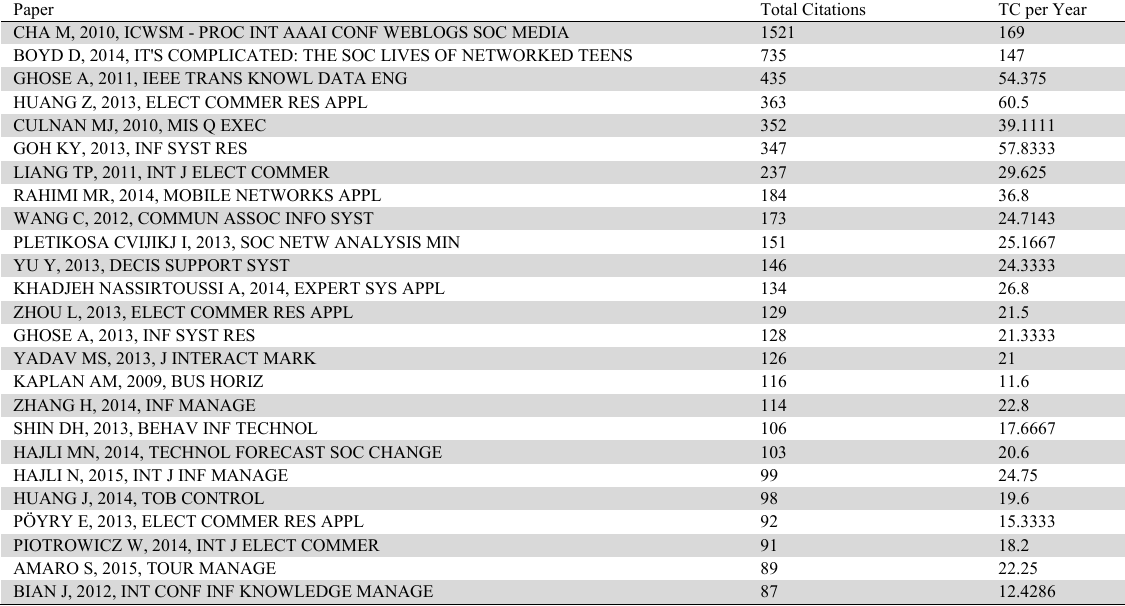
The summary of the most cited